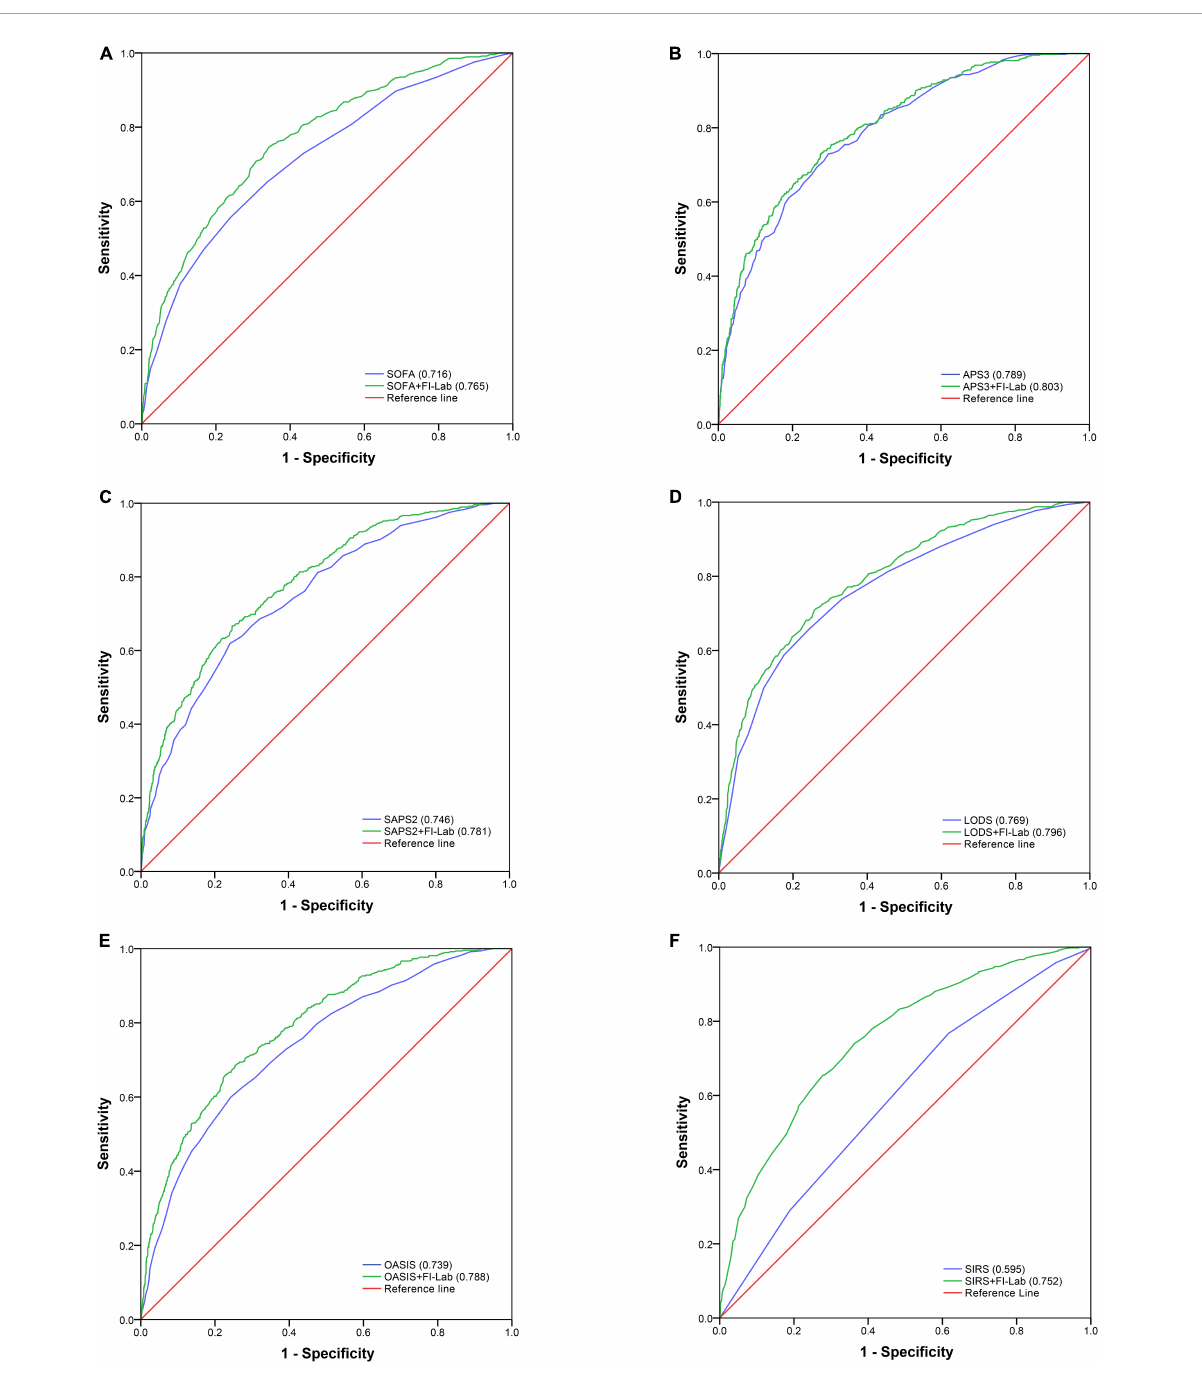
FIGURE2 Area under the receiver operator curve for in-hospital mortality.